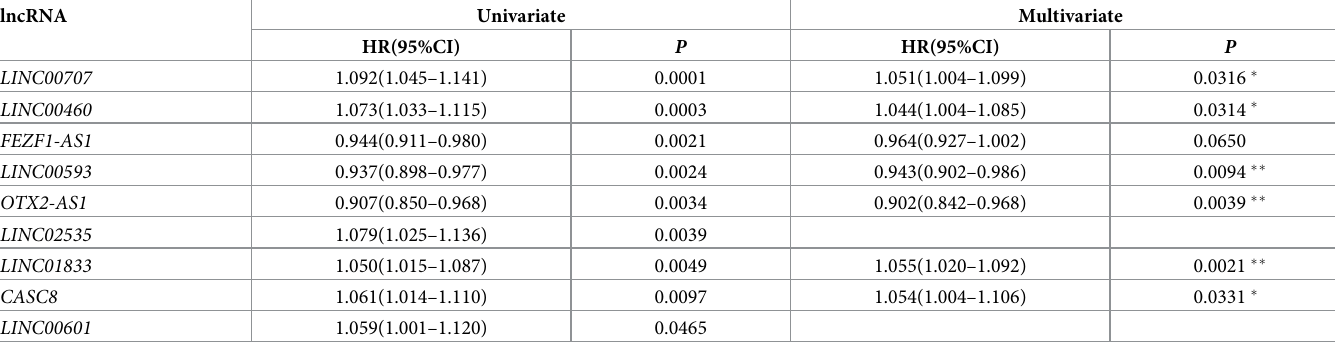
Table 4. Univariate and multivariate cox proportional hazard regression analysis of 9